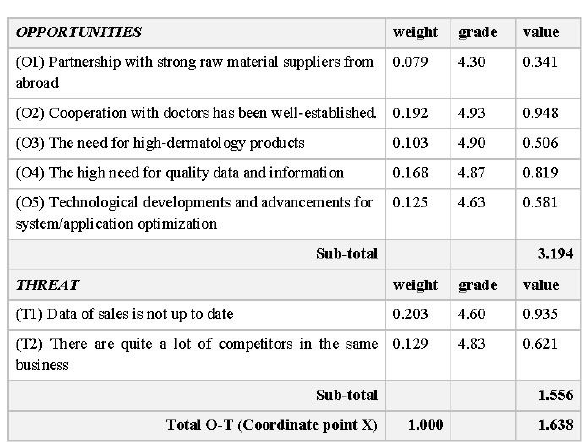
Figure 7: EFAS Table